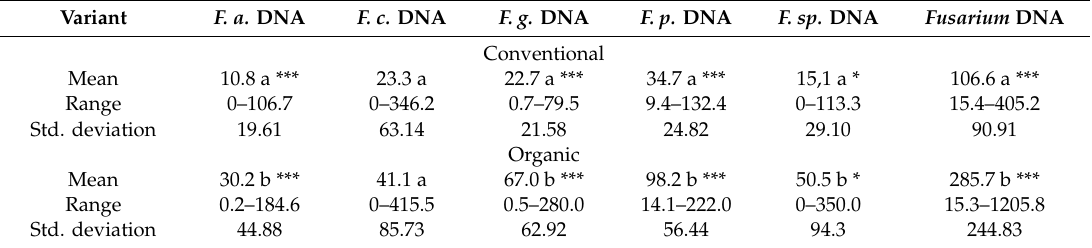
Table 6. Concentration of DNA (pg 100 ng − 1 of wheat DNA) of five Fusarium species in grain of 30 wheat cultivars grown in conventional and organic fields.